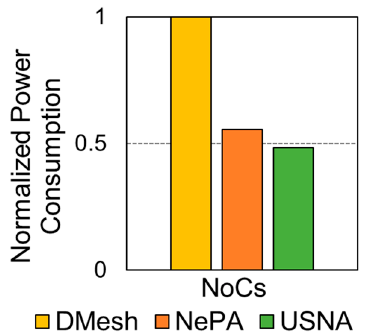
Figure 10. Comparison of normalized power consumption.